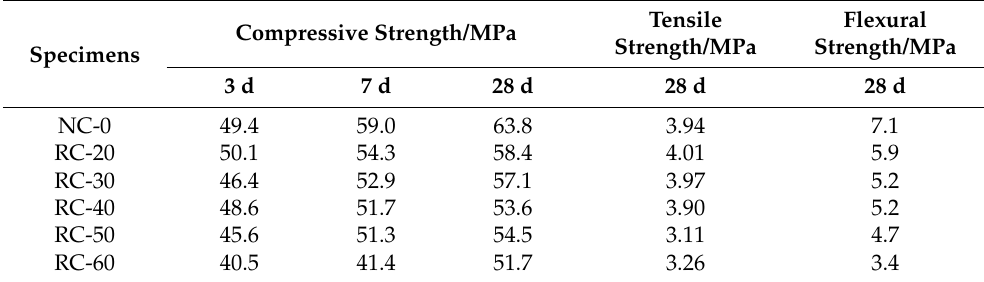
Table 4. Measured results of the mechanical property of recycled concrete with different recycled aggregate